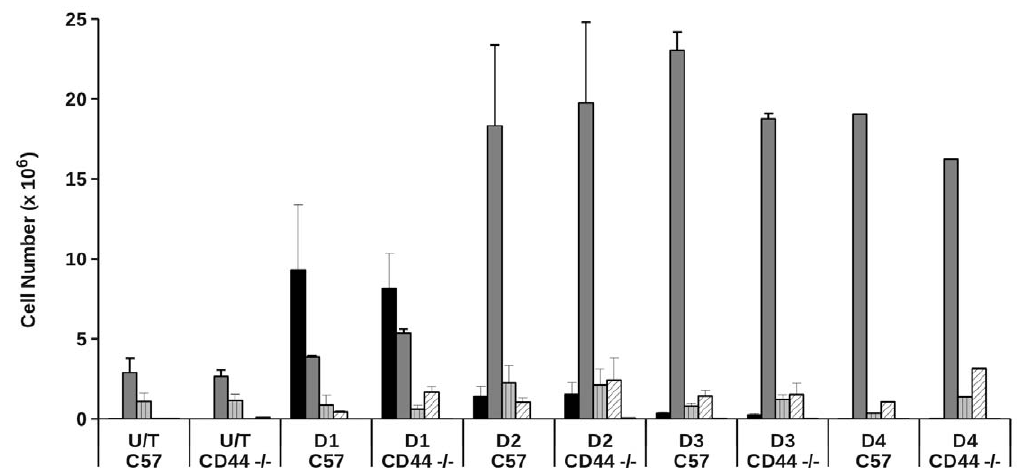
Figure 9. Thioglycollate-induced cell recruitment patterns in CD44 2 / 2 animals. Peritonitis was induced in wild type (C57BL/6J) or CD44 2 / 2 animals by injection of 2.5 ml of thioglycollate. At time points indicated, estimates of the total cell counts and percentage of cell types present in the peritoneal lavage fluid was made by microscopy and flow cytometry and the total counts for different cell populations calculated. Data are mean cell numbers 6 SEM from 5 separate experimental animals. Black bars: neutrophils, dark grey bars: macrophages, grey hatched bars: lymphocytes, white hatched bars: eosinophils, other bar: mast cells.